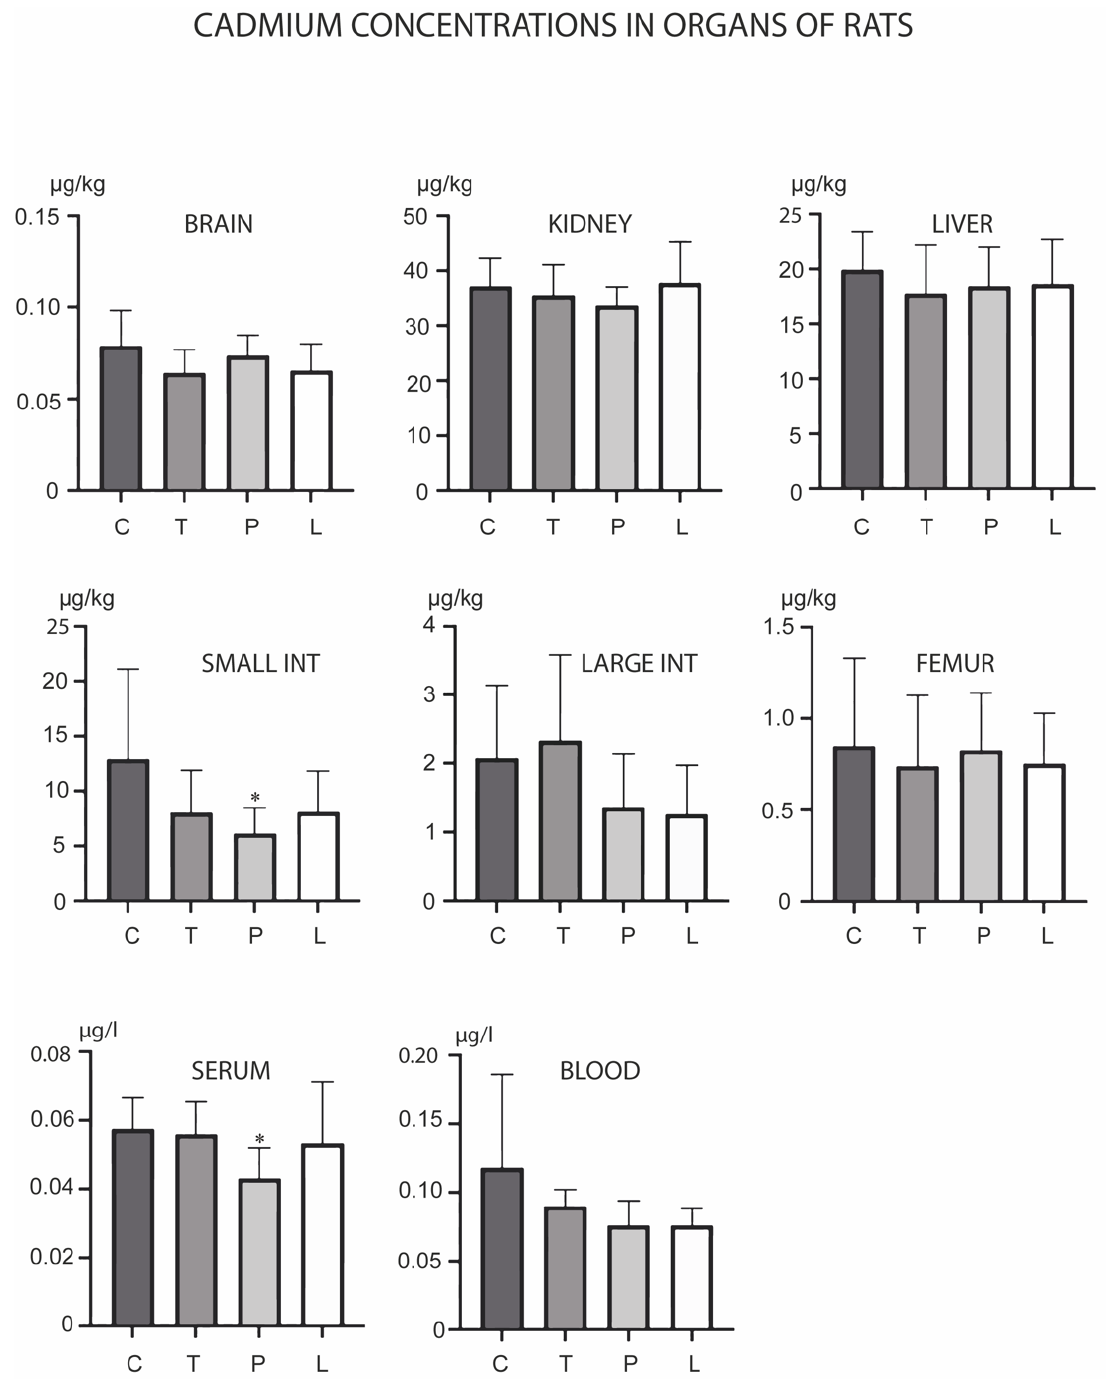
Figure 3. Concentrations of cadmium in the brain, kidney, liver, small intestine, large intestine, serum, blood and femur after the three-month oral administration of silicates. C denotes the control group; T denotes the experimental group receiving TMAZ; P denotes the experimental group receiving PMA; and L denotes the experimental group receiving Ludox silica. Asterisk (*) denotes significant differences between the experimental groups, with control at p < 0.05.